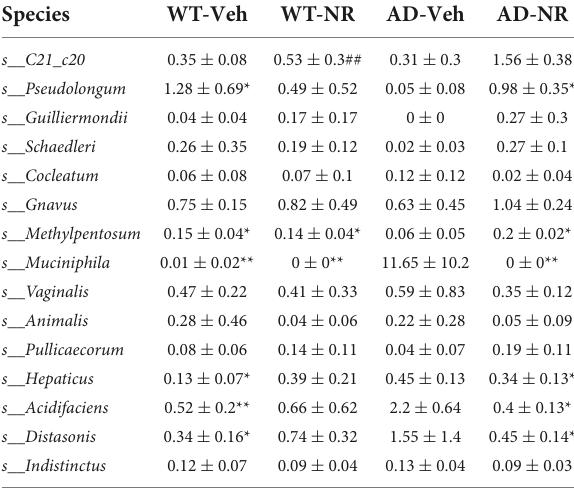
TABLE 4 The relative abundance (%) analysis at the species